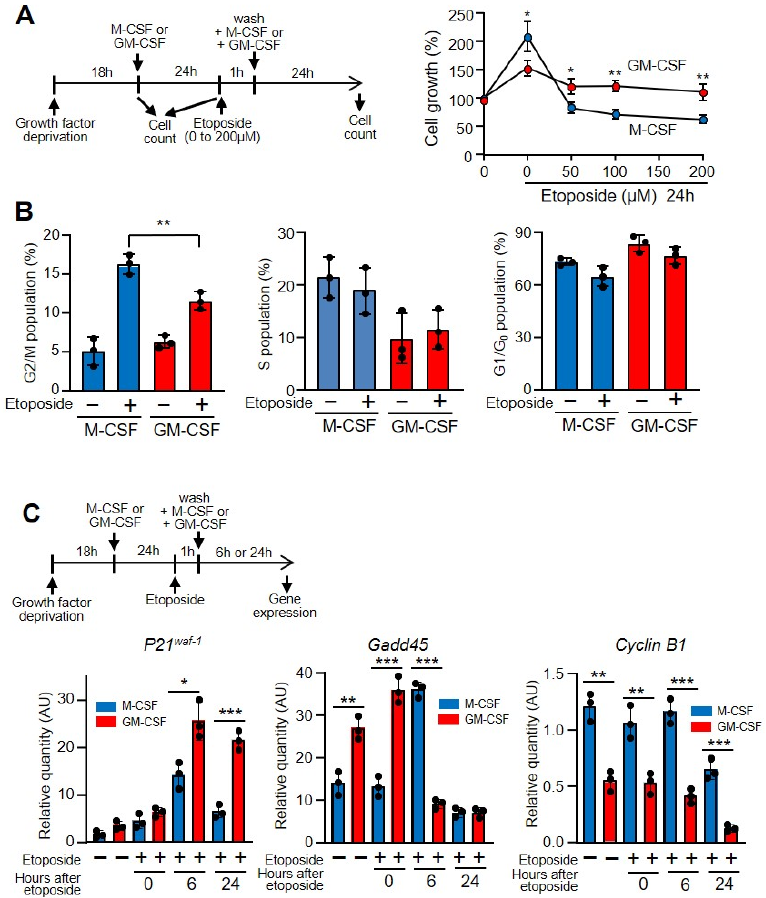
Figure 3. GM-CSF protected against the effects of etoposide on macrophage proliferation. ( A ) The experimental design is shown at the top. Macrophages were grown in M-CSF or GM-CSF (10 ng/mL) for 24 h, then treated for 1 h with the indicated amounts of etoposide, washed and incubated again with M-CSF or GM-CSF for 24 h, after which cell counting was performed using a hemocytometer ( n = 3). ( B ) Macrophages were treated as in A in the presence of 50 µM of etoposide and their DNA content was measured by flow cytometry to determine the cell cycle ( n = 3). ( C ) The experimental design is shown at the top. Macrophages were cultured in the presence of M-CSF or GM-CSF for 24 h, then incubated with etoposide for 1 h (50 µM), washed and incubated again for 6 or 24 h. Gene expression was analyzed by real-time PCR ( n = 3). Each experiment was performed in triplicate, and the results are shown as the mean ± SD. * p < 0.05, ** p < 0.01 and *** p < 0.001 in relation to the corresponding treatments with M-CSF or GM-CSF, when all the independent experiments had been compared. Data were analyzed using Student’s t -test, with the exception of ( C ), which was performed using ANOVA test.